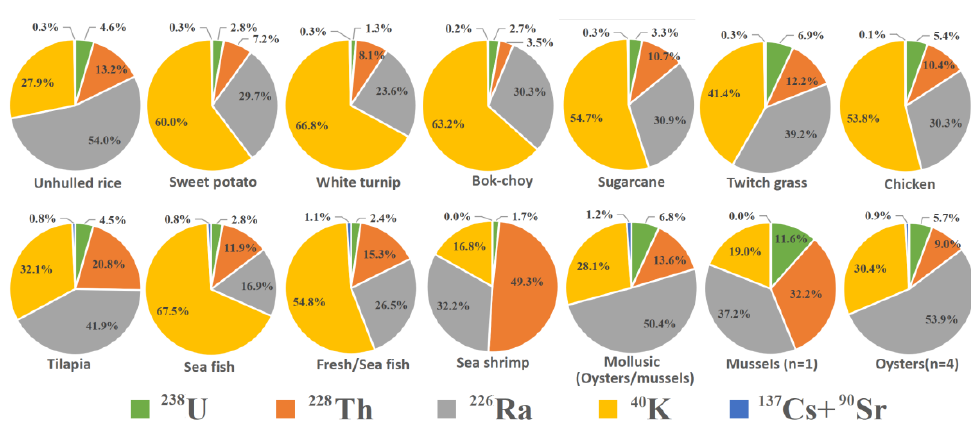
Figure 5. Dose contributions of each radionuclide.